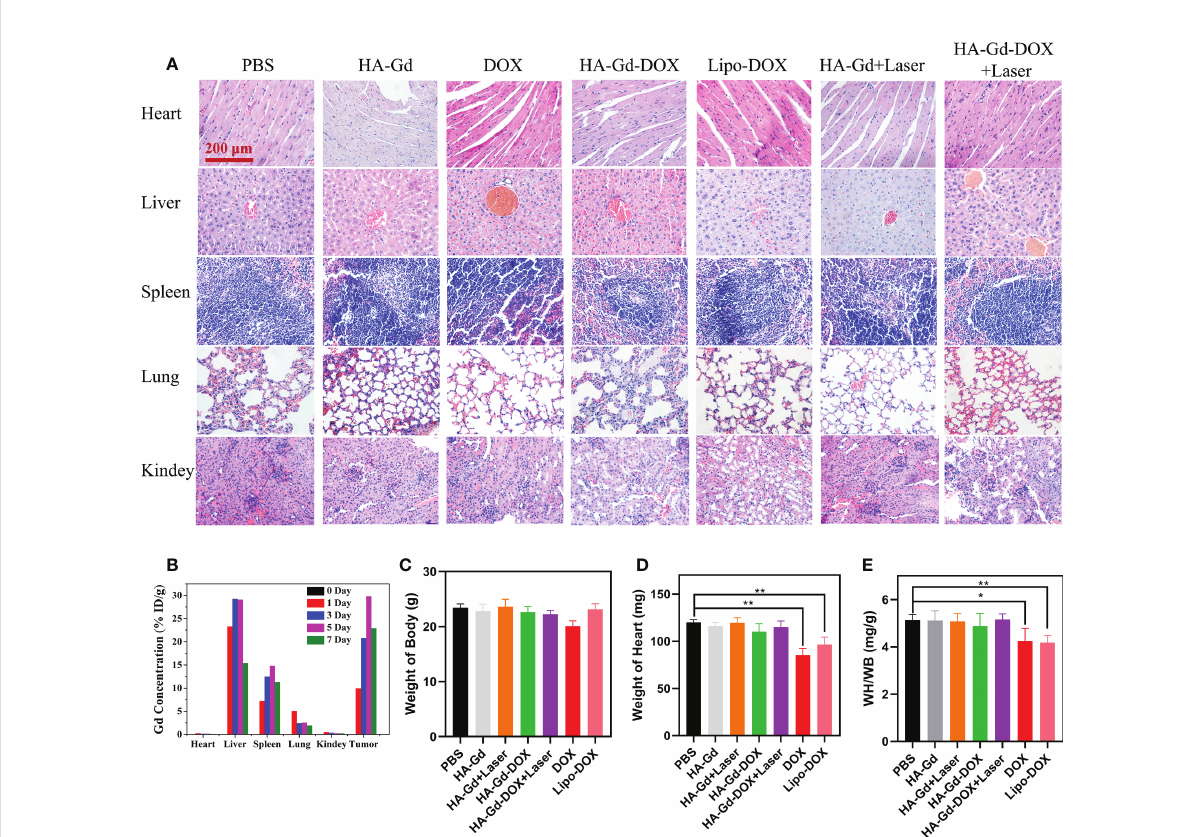
FIGURE 6 (A) Histopathologic examination of the tissues from tumor-bearing mice after different treatments. (B) Distribution of Gd element in tissues after tail vein injection of HA-Gd-DOX (15 mg/kg). Body weight (C) , heart weight (D) , and cardioplasmic ratio (E) of tumor-bearing mice with different treatments after 14 days ( n = 5, * p < 0.05, ** p < 0.01; the signi fi cance of experimental results was analyzed by two-tailed Student ’ s t